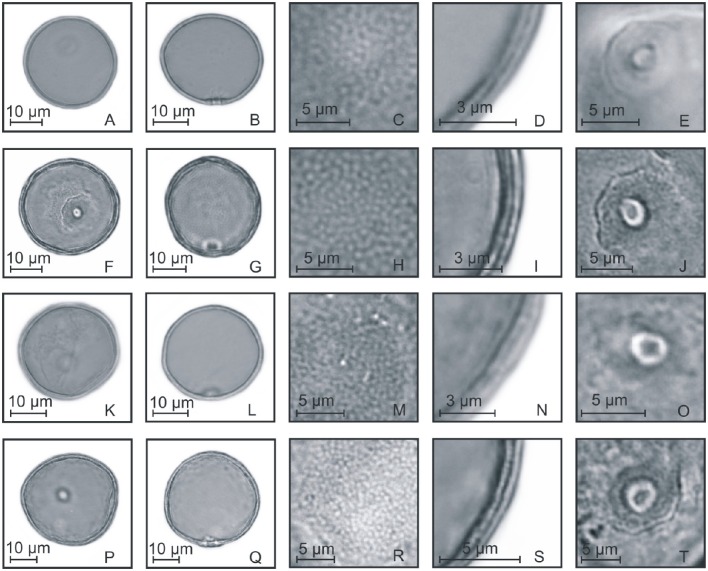
Pollen grains of the subfamilies Chloridoideae, Aristidoideae, and Pooideae. (A–E)
Pappophorum philippianum: PV (A), EV (B), detail of ornamentation (C), detail of the thickness of the exine (D), and detail of the aperture (E); (F–J)
Aristida sp.: PV (F), EV (G), detail of ornamentation (H), detail of the thickness of the exine (I), and detail of the aperture (J); (K–O)
Chascolytrum subaristatum: PV (K), EV (L), detail of ornamentation (M), detail of the thickness of the exine (N), and detail of the aperture (O); (P–T)
Bromus catharticus: PV (P), EV (Q), detail of ornamentation (R), detail of the thickness of the exine (S), and detail of the aperture (T).